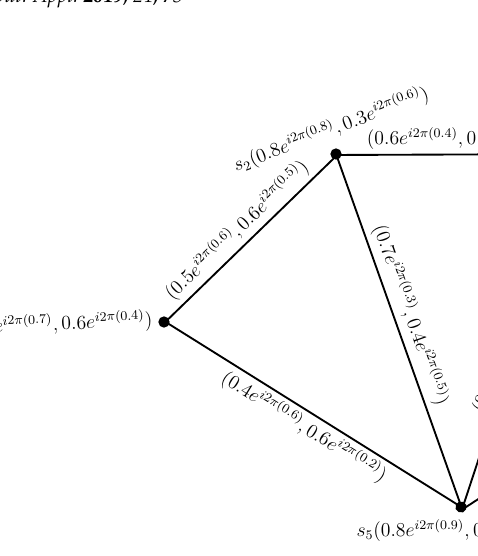
Figure 1. Complex Pythagorean fuzzy graph. Figure 1: Complex Pythagorean fuzzy graph.